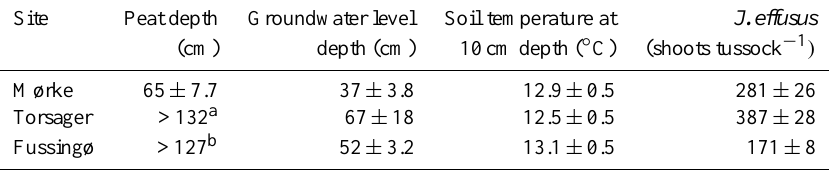
Table 1. Peat depth, groundwater level depth, soil temperature at 10cm depth and number of shoots in tussocks of J. effusus at the three study sites. Data are mean ± standard error ( n = 4, n = 8, n = 16 and n = 16 respectively) representing spatial variability for peat depth and temporal variability within sites for groundwater level, soil temperature and tussocks of J. effusus .